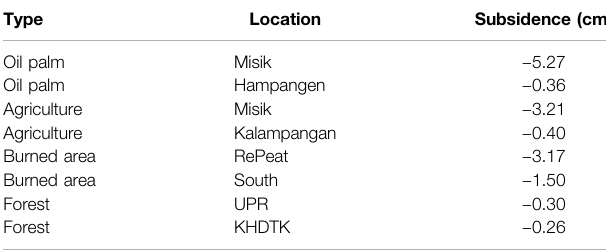
TABLE 2 | Annual net subsidence for 2019 for the Kalimantan